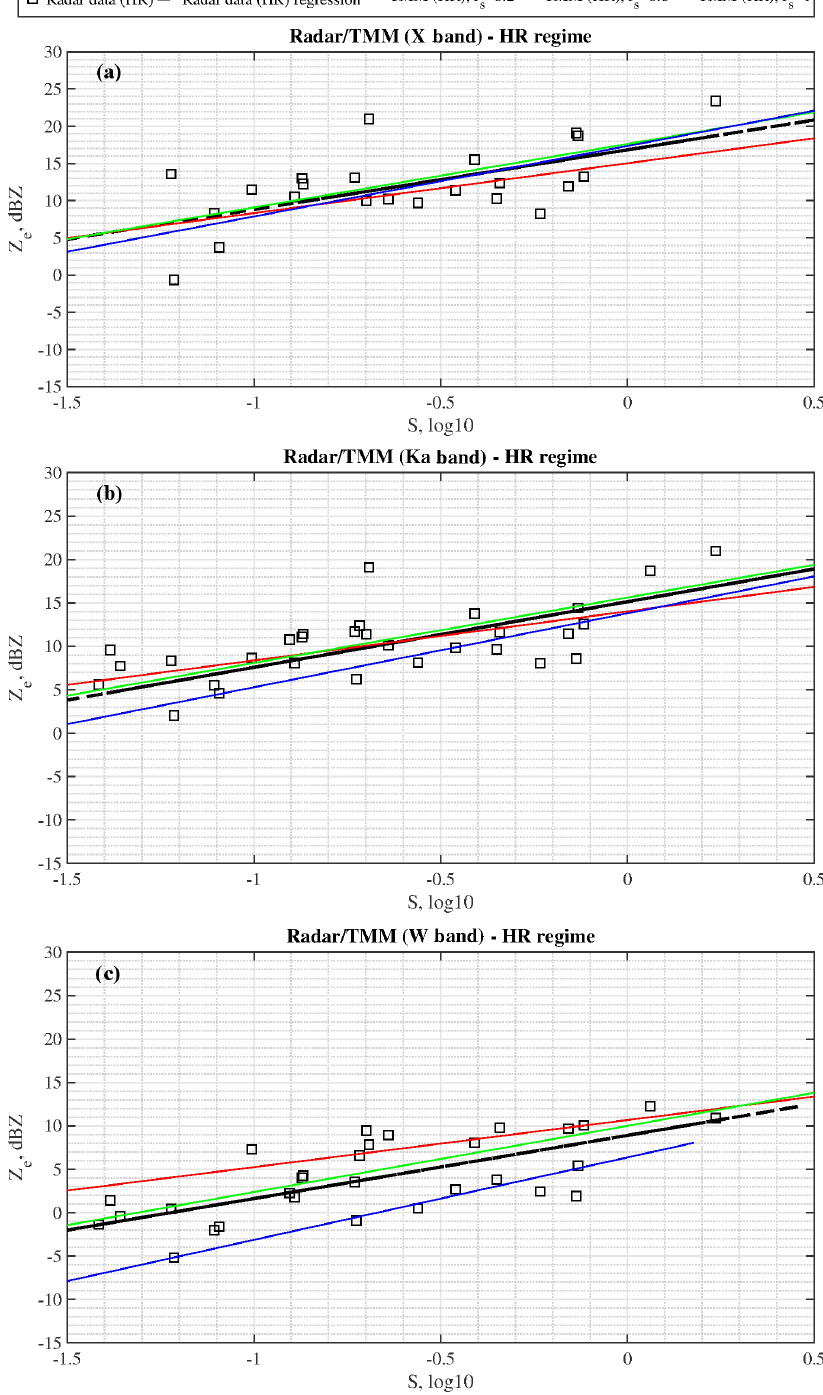
Figure 6. Same as Fig. 4 but for heavily rimed (HR) snowfall cases. Scatterplot is now represented by black squares.